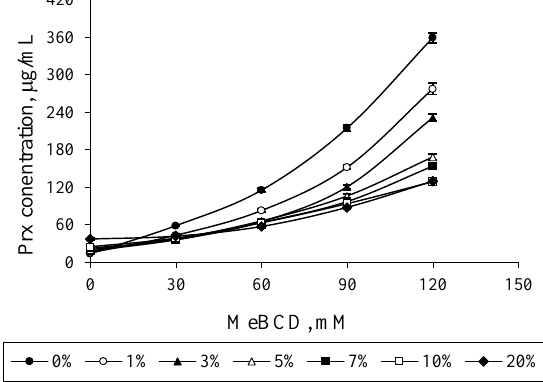
Figure 8. Effect of ethanol on the solubility of Prx in Prx–MeBCD–ethanol ternary mixtures varying MeBCD